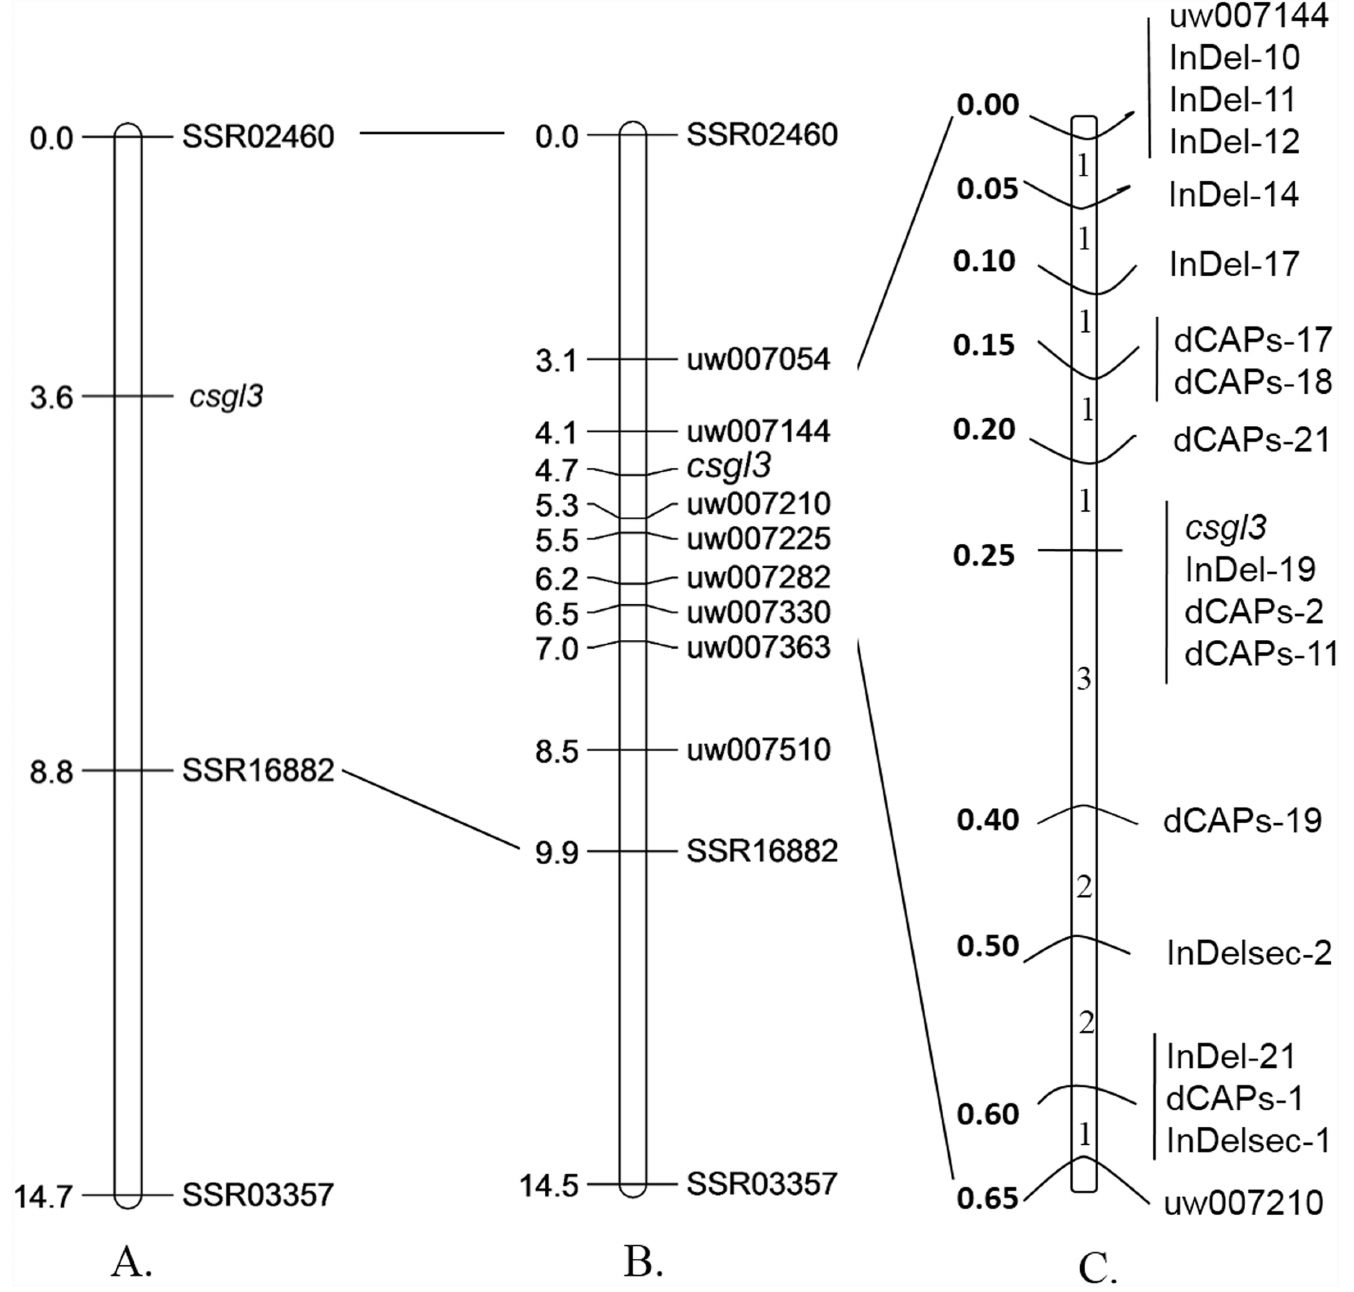
Fig 3. Fine mapping of the putative csgl3 gene in cucumber. Map distance is given in centimorgans (cM).